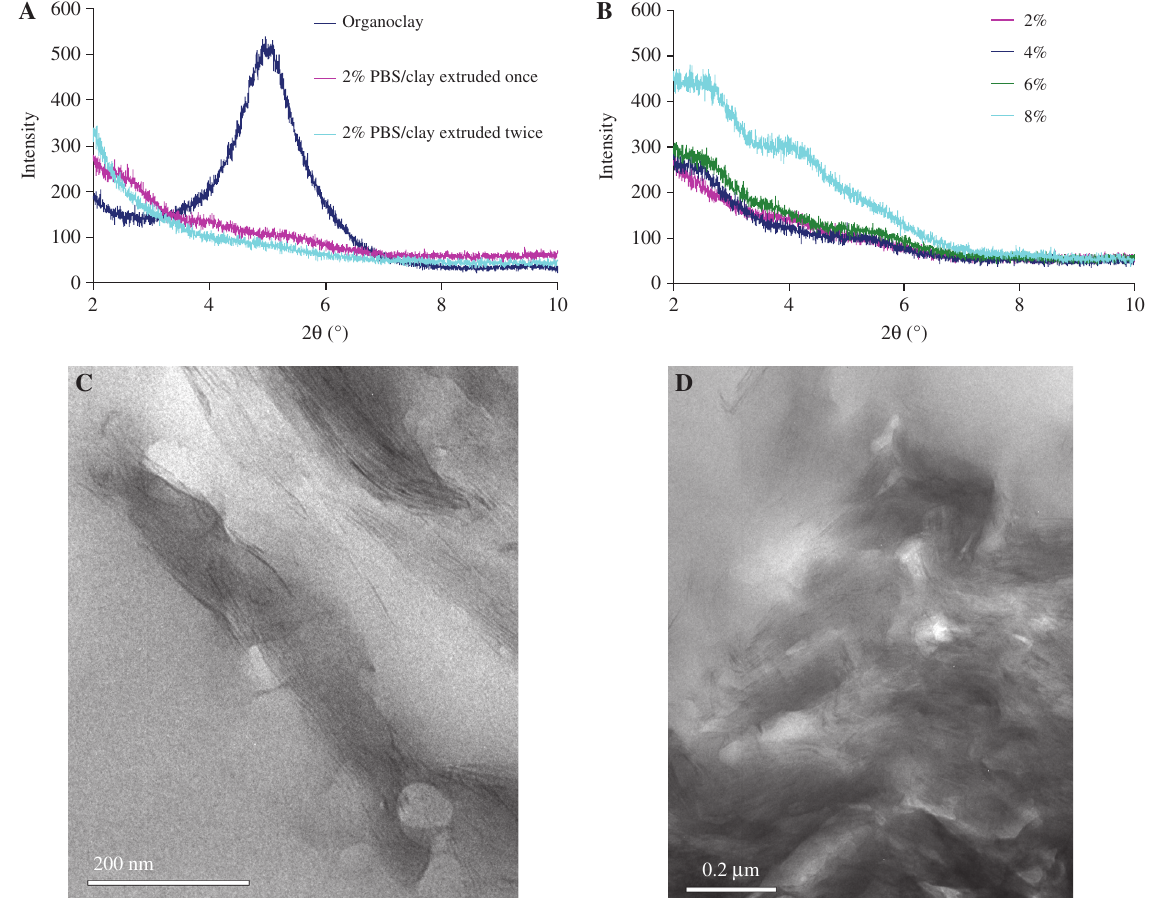
Figure 2 Dispersion state of organoclay illustrated by XRD of (A) as-received organoclay powder and extruded composites with 2 wt% organoclay, (B) PBS/organoclay composites with varying clay content, and TEM morphologies of (C) 2 wt% PBS/clay composites and (D) 6 wt% PBS/clay